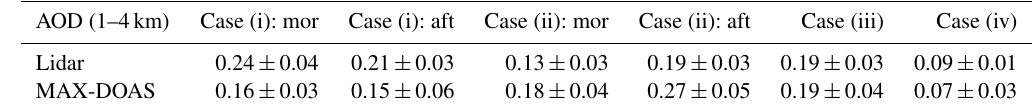
Table 7. MAX-DOAS (477nm) and lidar (532nm) AOD calculations for the atmospheric layer